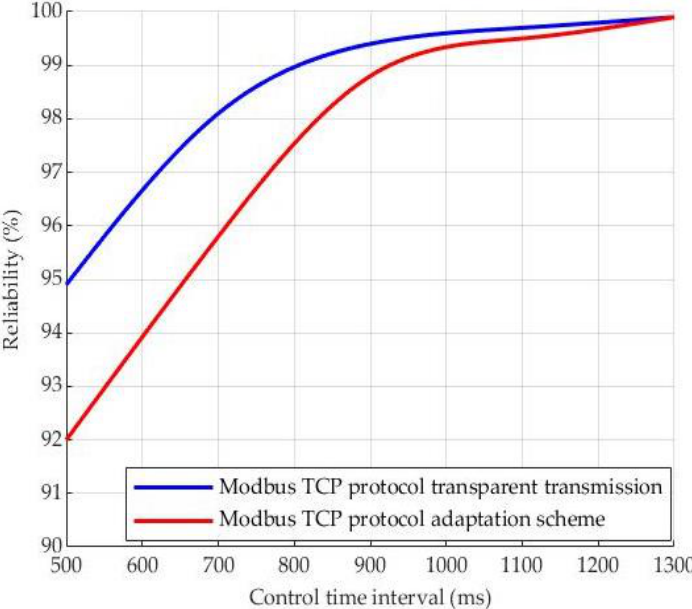
Figure 20. The reliability comparison between protocol adaptation and prototype transparent trans- mission for Modbus TCP.